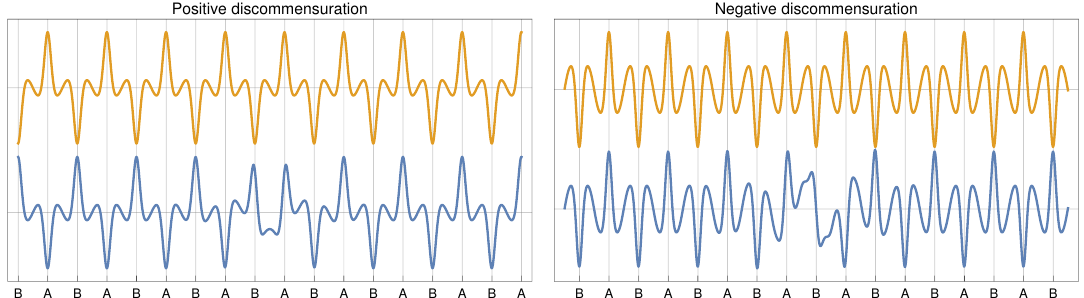
Figure 7 . Current pro(cid:12)le a discommensuration (blue curves) as compared to the current pro(cid:12)le of the \parent" commensurate state (yellow curves). Both cases clearly show a domain wall, which shift the staggered A (cid:0) B order by half of a period. The positive disc. is considered at A = 1, the negative | at A =